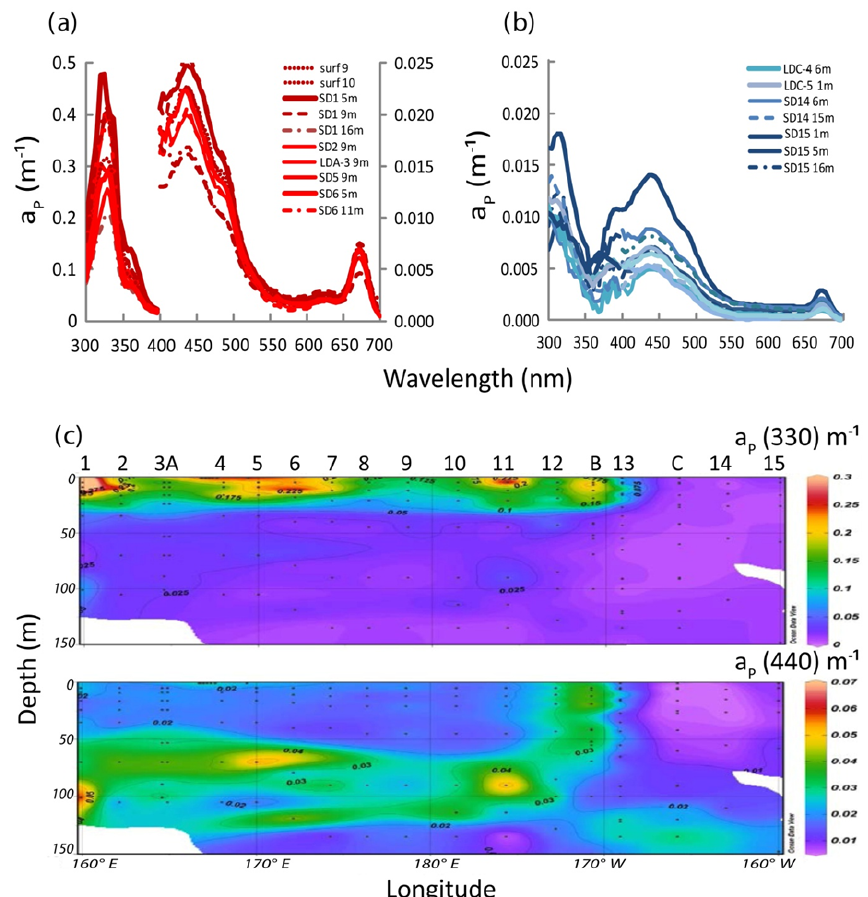
Figure 9. IOPs (continued): (a) in situ absorption spectrum of Trichodesmium -rich waters as measured by the filter technique showing MAA absorption (on frozen filters) at 330 and 360nm. Note the two different axes for 330nm (left y axis) and for 440nm (right y axis) and (b) idem for Trichodesmium -poor waters (only one y axis), (c) OUTPACE section of a P (330) (upper panel) and a P (440) (lower panel). Source: Ocean Data View (sections Schlitzer, R., Ocean Data View, http://odv.awi.de,